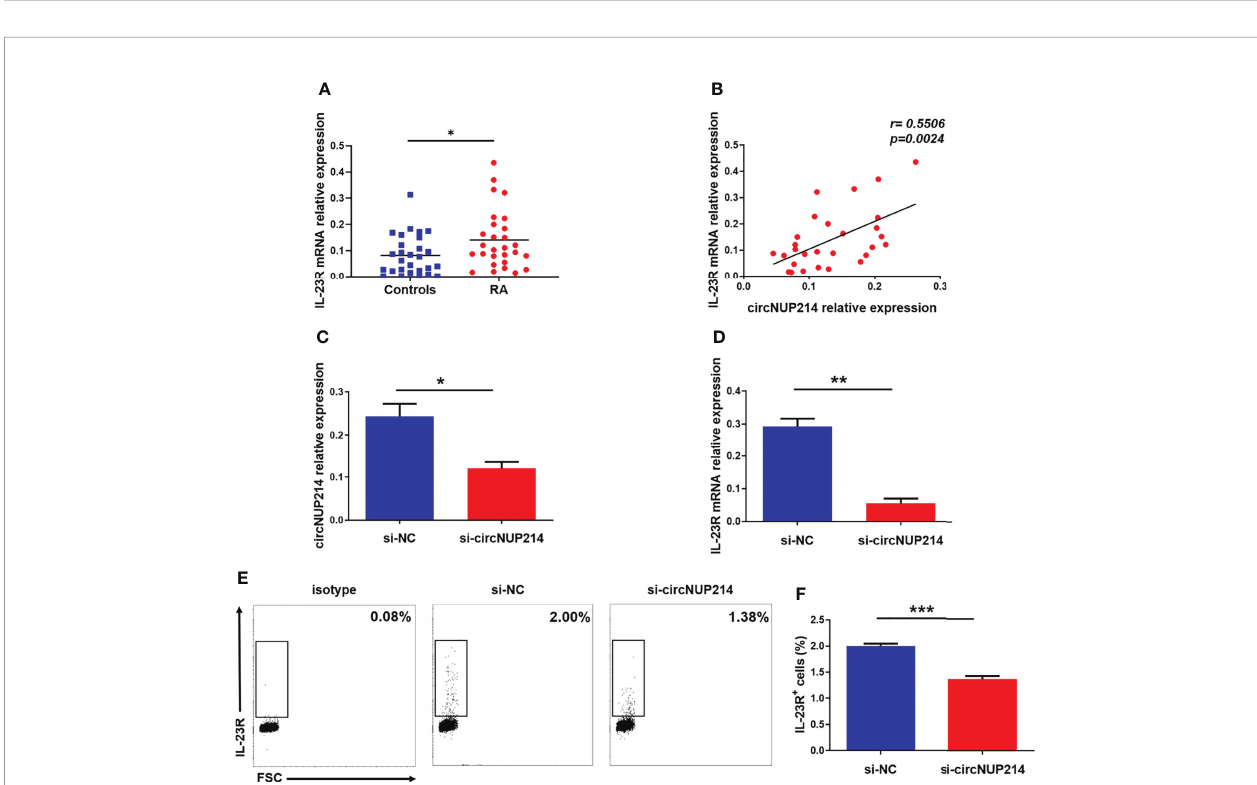
FIGURE 3 | Effect of circNUP214 on IL-23R expression in RA patients. (A) The transcript levels of IL-23R mRNA in PBMCs from 28 RA patients and 28 controls were determined by qRT – PCR. (B) The correlation between circNUP214 expression and IL-23R levels in 28 RA patients. Each data point represents an individual subject, and the horizontal lines show the mean. (C) The transcript levels of circNUP214 were detected by qRT – PCR after transfection with circNUP214-speci fi c siRNA and negative control (si-NC) in human CD4 + T cells. (D) IL-23R mRNA expression was detected by qRT – PCR after transfection with si-circNUP214 and si-NC. (E, F) The percentage of IL-23R + cells were analysed by fl ow cytometry. Data represent mean ± S.D. from three independent experiments. * p < 0.05; ** p < 0.01; *** p < 0.001.